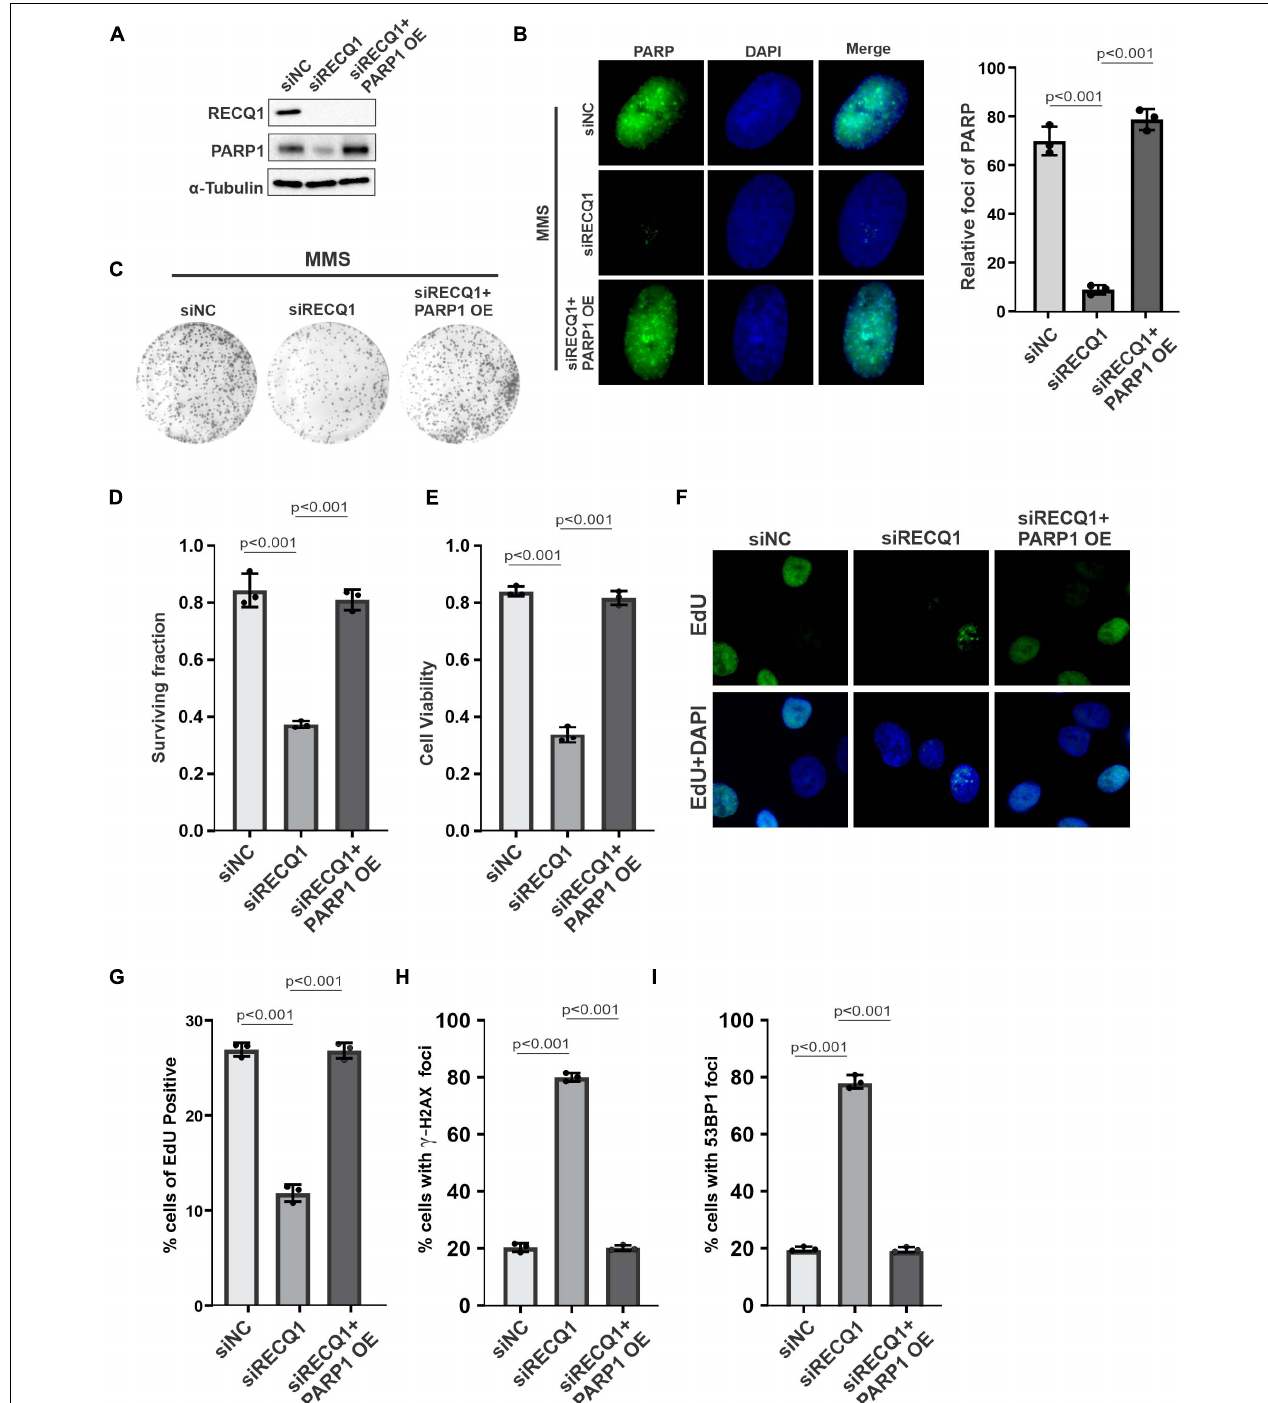
FIGURE 5 | PARP1 compensated RECQ1 dysfunction on GBM cells growth upon replication stress. (A) Whole-cell lysates from M059K cells transfected with siNC, siRECQ1, or siRECQ1 and PARP1 OE (overexpression plasmid) were analyzed by western blotting using the indicated antibodies. (B) Immunofluorescence indicates PARylation in cells transfected with siNC, siRECQ1, or siRECQ1 and PARP1 OE. (C) Representative images of colonies. (D) Quantification of colony formation assay of cells transfected with siNC, siRECQ1 or siRECQ1 and PARP1 OE exposed to MMS. (E) The viability of transfected M059K cells was measured with a CCK8 kit. (F,G) Cell proliferation was measured by an EdU labeling of immunofluorescence. Quantification of EdU positive cells were calculated. (H,I) γ -H2AX and 53BP1 staining indicated DSB accumulation. Quantification are represented as means ± SD from at least three independent experiments. A two-sided unpaired t -test was used to calculate P -values. Significant: p < 0.05; NS, not significant: P > 0.05.